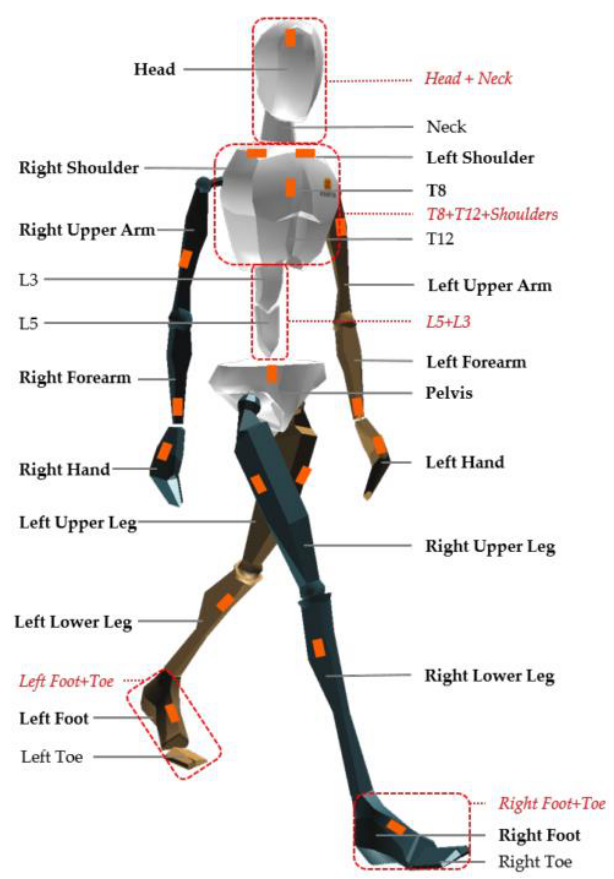
Figure 7. Biomechanical model and landmarks for IMUs as proposed by [45].